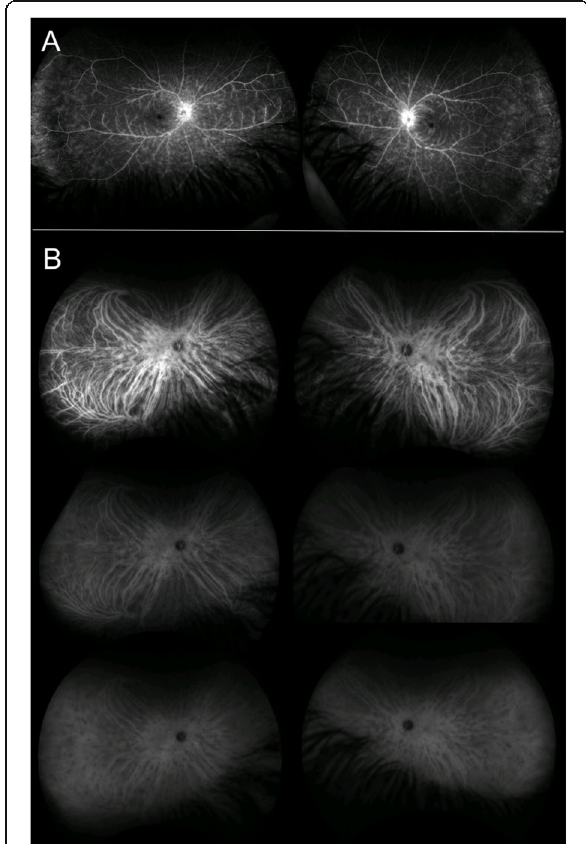
Fig. 6 Birdshot retinochoroiditis. A Ultra-wide field fluorescein angiography of both eyes showing optic nerve hyperfluorescence and diffuse vascular leakage. B Ultra-wide field indocyanine angiography of both eyes showing active choroidal inflammatory lesions appear hypofluorescent throughout the exam, showing extension of the disease from choroidal stroma to